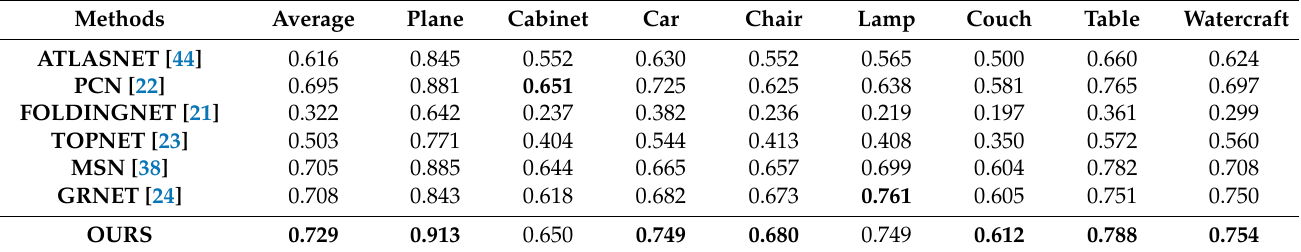
Table 2. Point completion results on PCN dataset in terms of F-score computed on 16,384 points. The best results are highlighted in bold (higher is